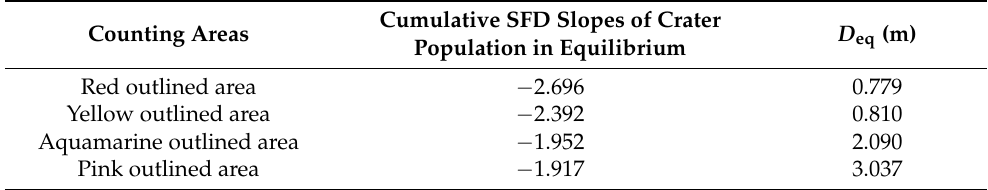
Table 3. Summary of the equilibrium states of the crater populations on the counting areas. Cumulative SFD Slopes of Crater D eq (m) Counting Areas Population in Equilibrium Red outlined area − 2.696 0.779 Yellow outlined area − 2.392 0.810 Aquamarine outlined area − 1.952 2.090 Pink outlined area − 1.917